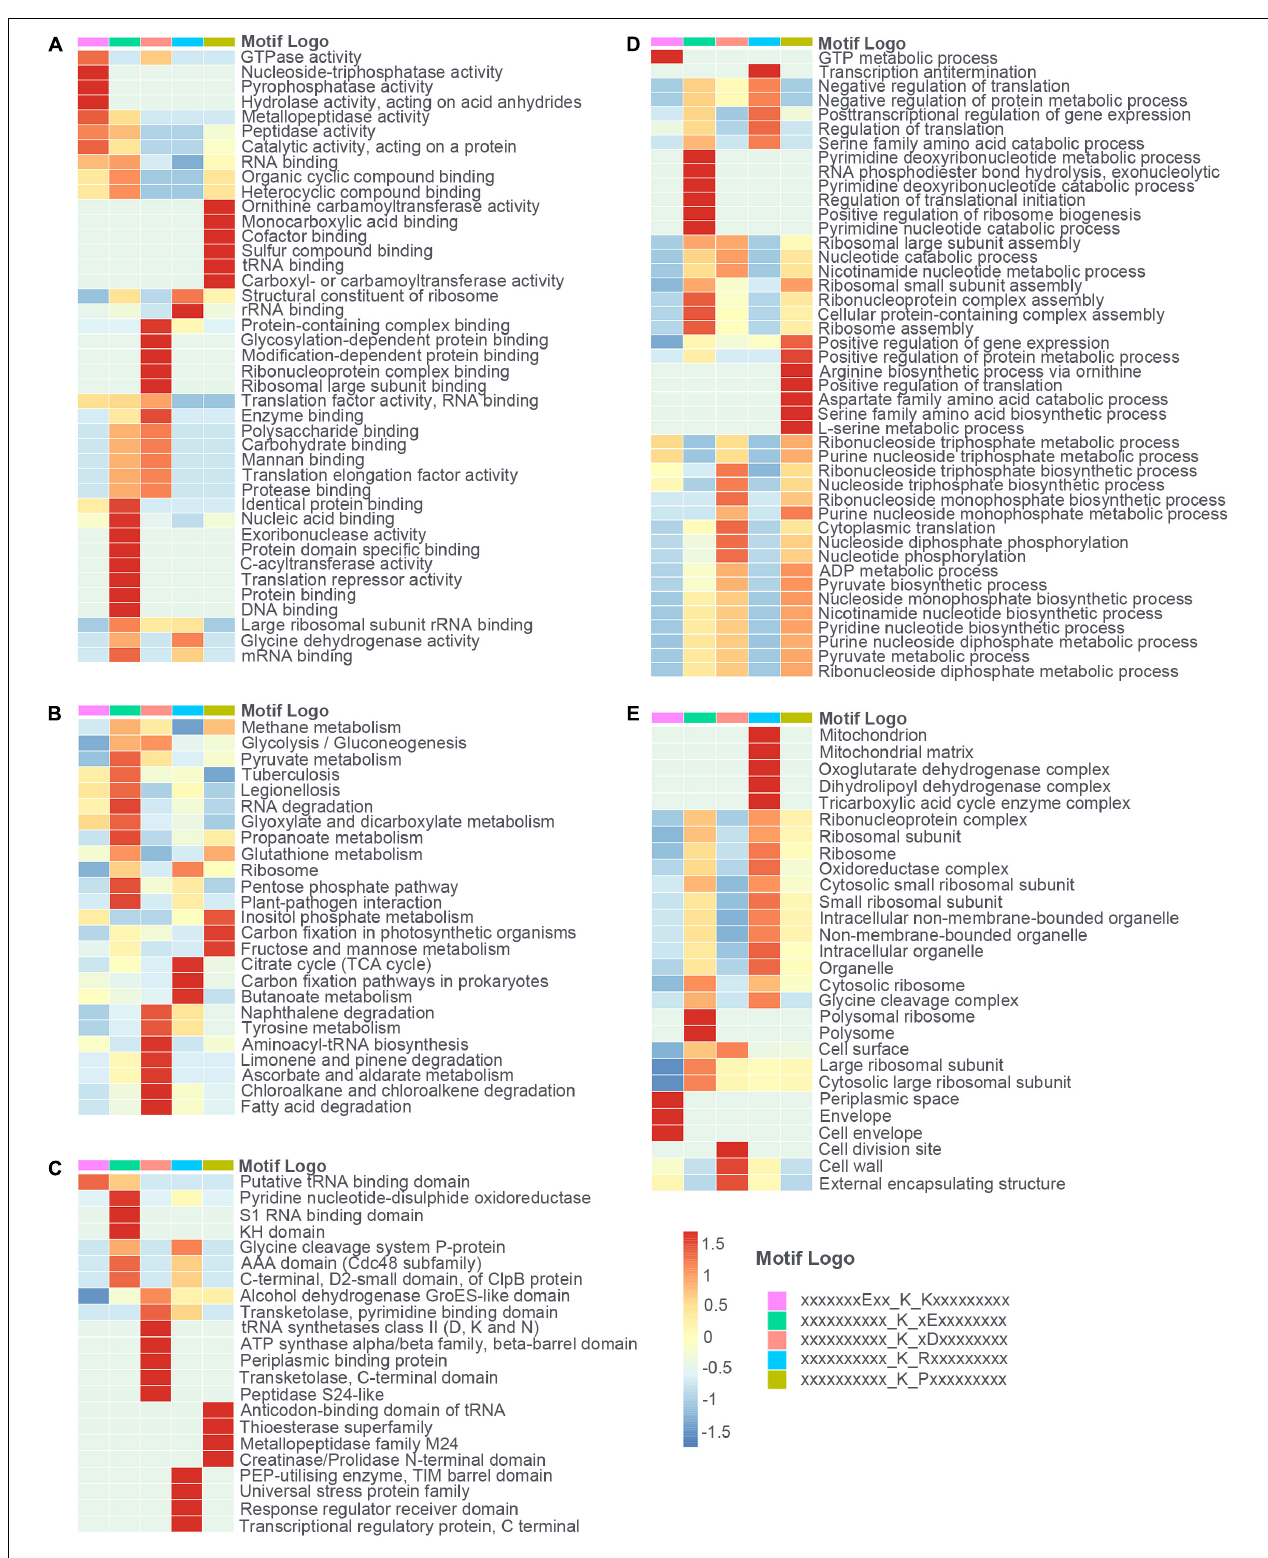
FIGURE 6 | The heat maps showed the enrichment analysis of proteins with each of the five motifs (E**KsuK, Ksu*E, Ksu*D, KsuR, and KsuP) in terms of (A) molecular function (MF), (B) KEGG pathway, (C) protein domain, (D) biological process (BP), and (E) cellular component (CC).